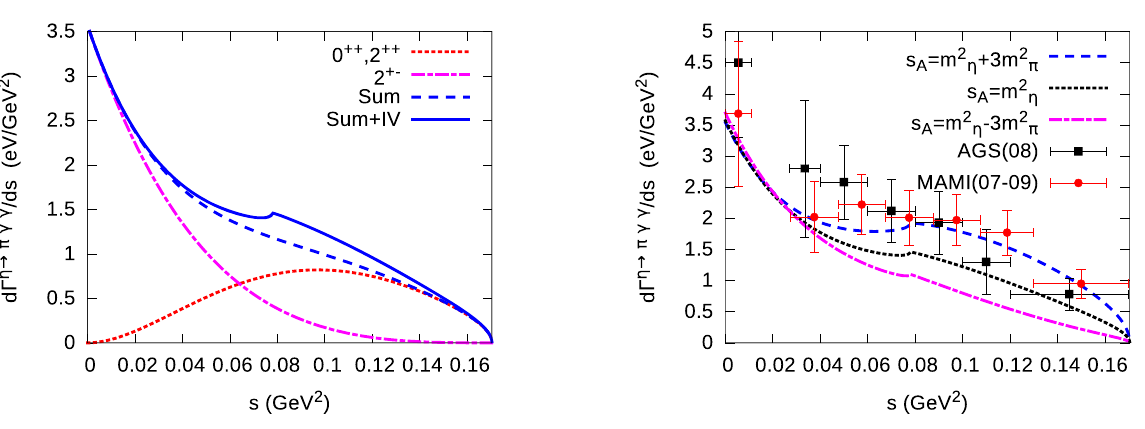
Fig. 10 Experimental data on the η → π 0 γγ energy distribution [14,15] compared with predictions from our amplitudes showing the influence of the position of the Adler zero starts to be dominating above the π + π − threshold. The fig- a visible cusp at this threshold. The central value of the decay width generated by our amplitudes is Γ = 0 .